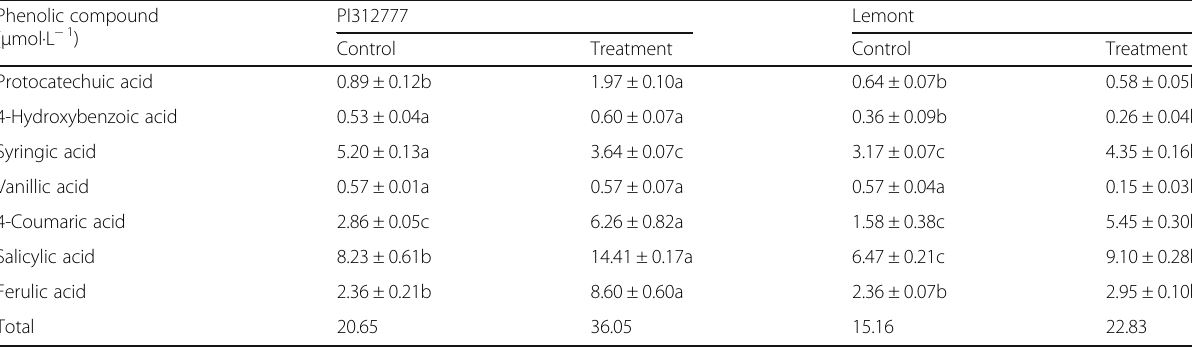
Table 1 Phenolic acid contents in the rice culture solutions